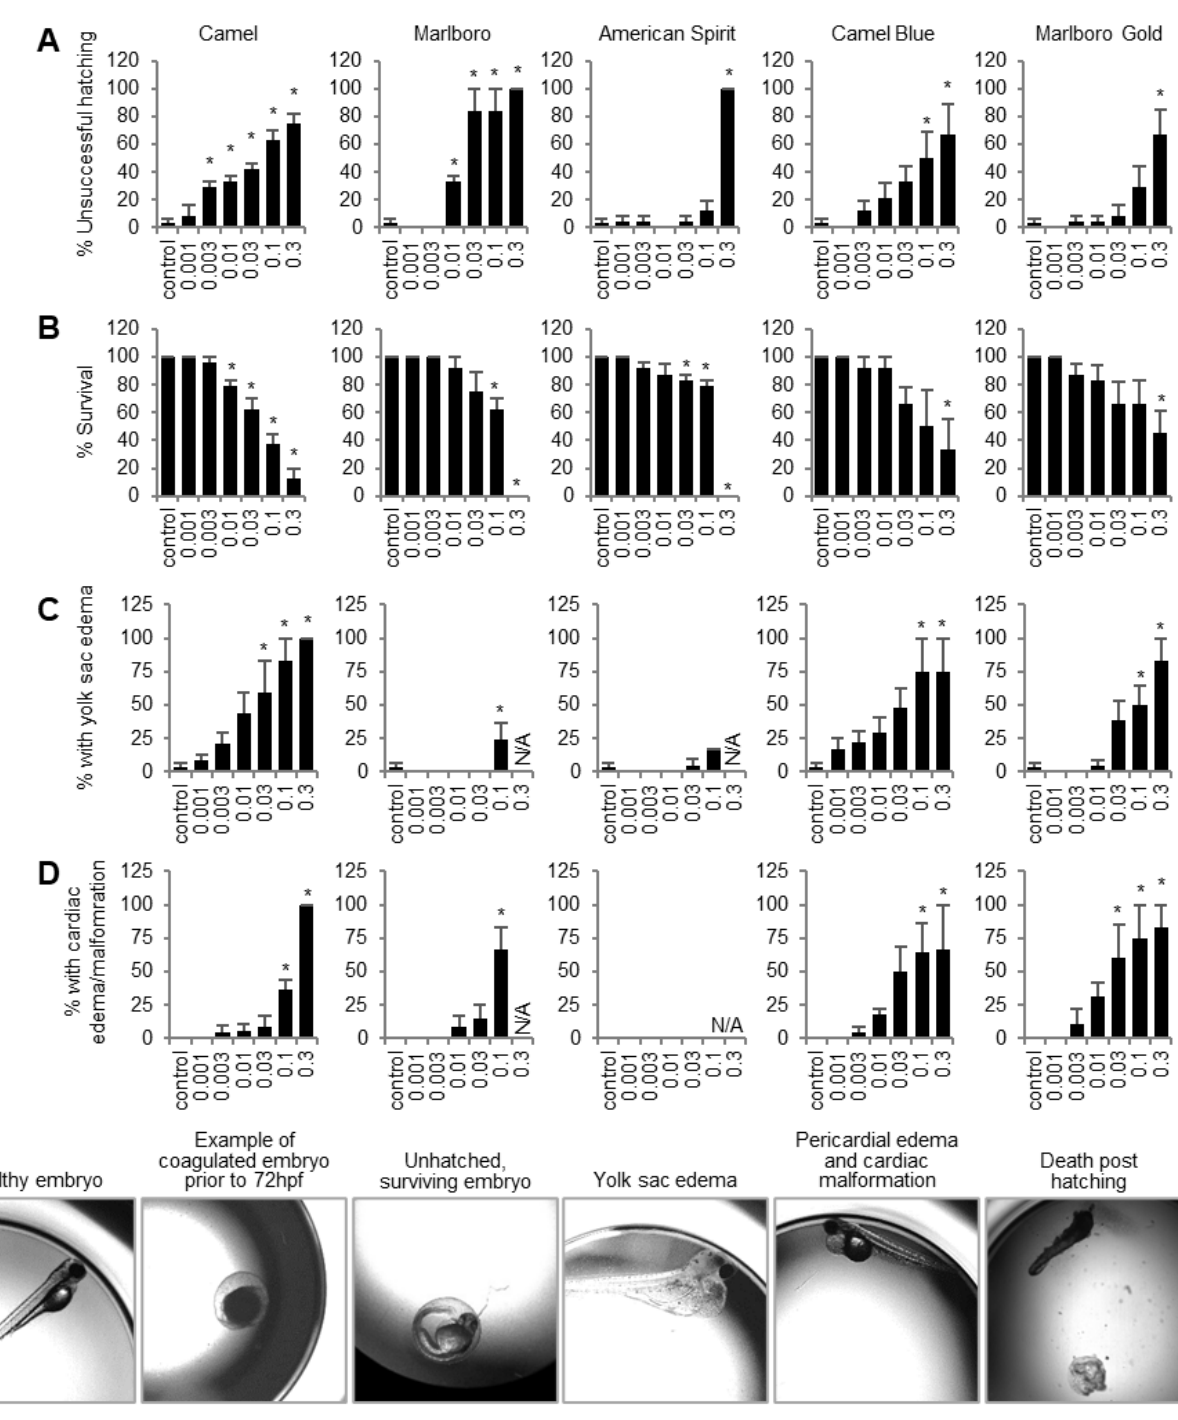
Figure 1. Tobacco products cause early developmental problems in zebrafish embryos. Embryos were placed in E3 embryo media containing tobacco smoke solution at varying concentrations at 5 hpf and assessed at 3 dpf and 6 dpf. Hatching success (3 dpf) ( A ) and survival (6 dpf) ( B ) was measured out of the original 24 embryos. Yolk sac edema ( C ) or defects in heart development ( D ) were assessed in the surviving larvae. X-axes represent concentrations in puff equivalents (PE). ( E ) Example images of phenotypes scored in ( A – D ). * p < 0.05, one-way ANOVA with a Dunnett’s post hoc test to correct for multiple comparisons. N/A, not assessed.